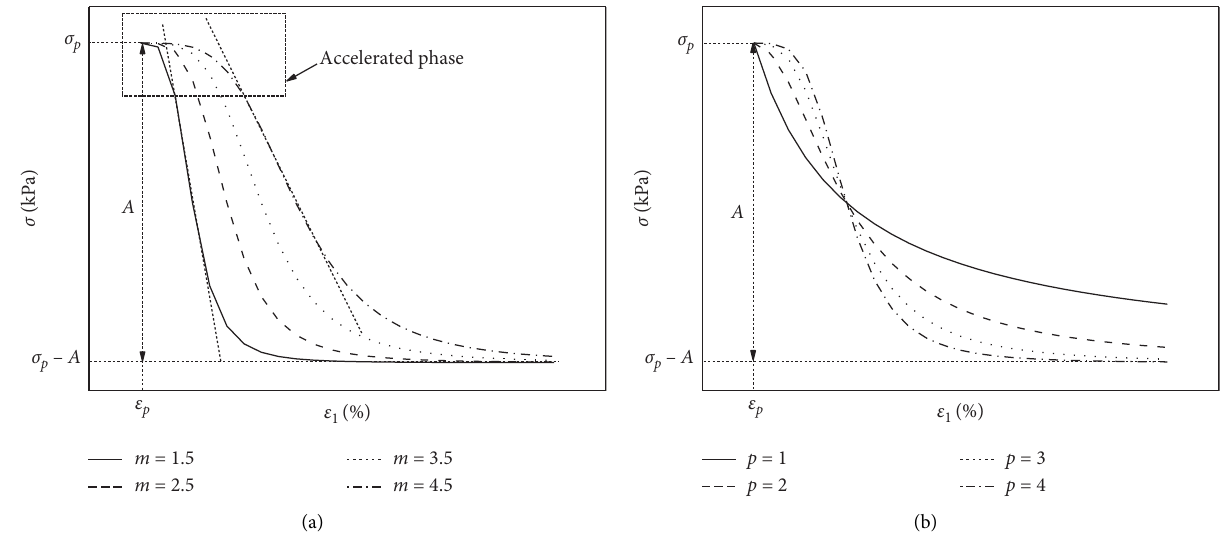
Figure 11: The influence of model parameters on the postpeak curve. Influence of (a) parameter m and (b) parameter p